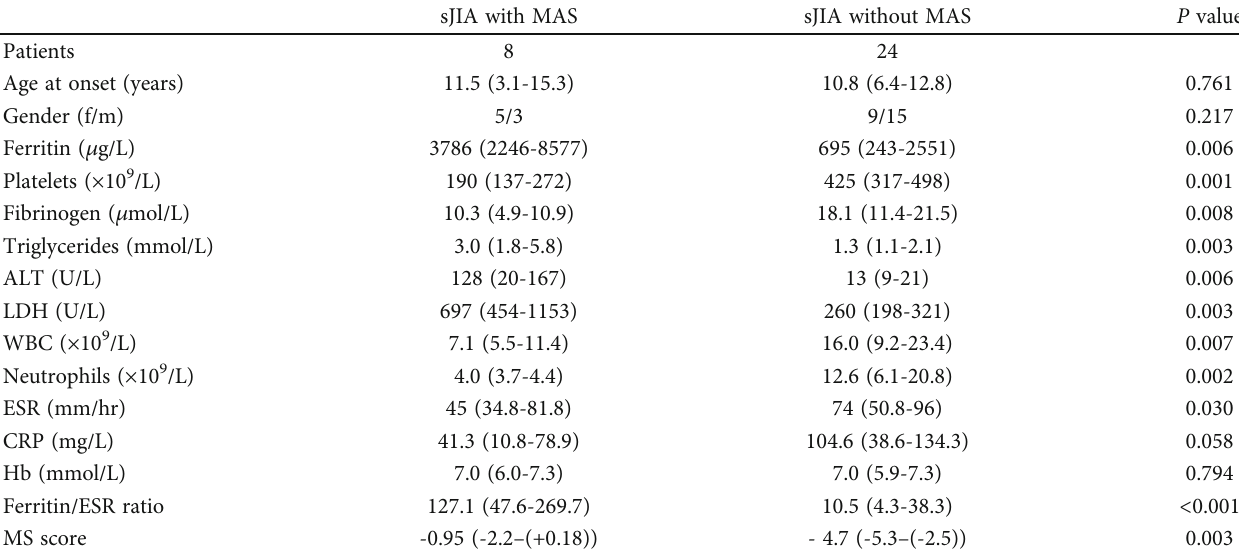
Table 3: Demographic characteristics and laboratory data in children with active SJIA with and without MAS according to the 2016 MAS classi fi cation